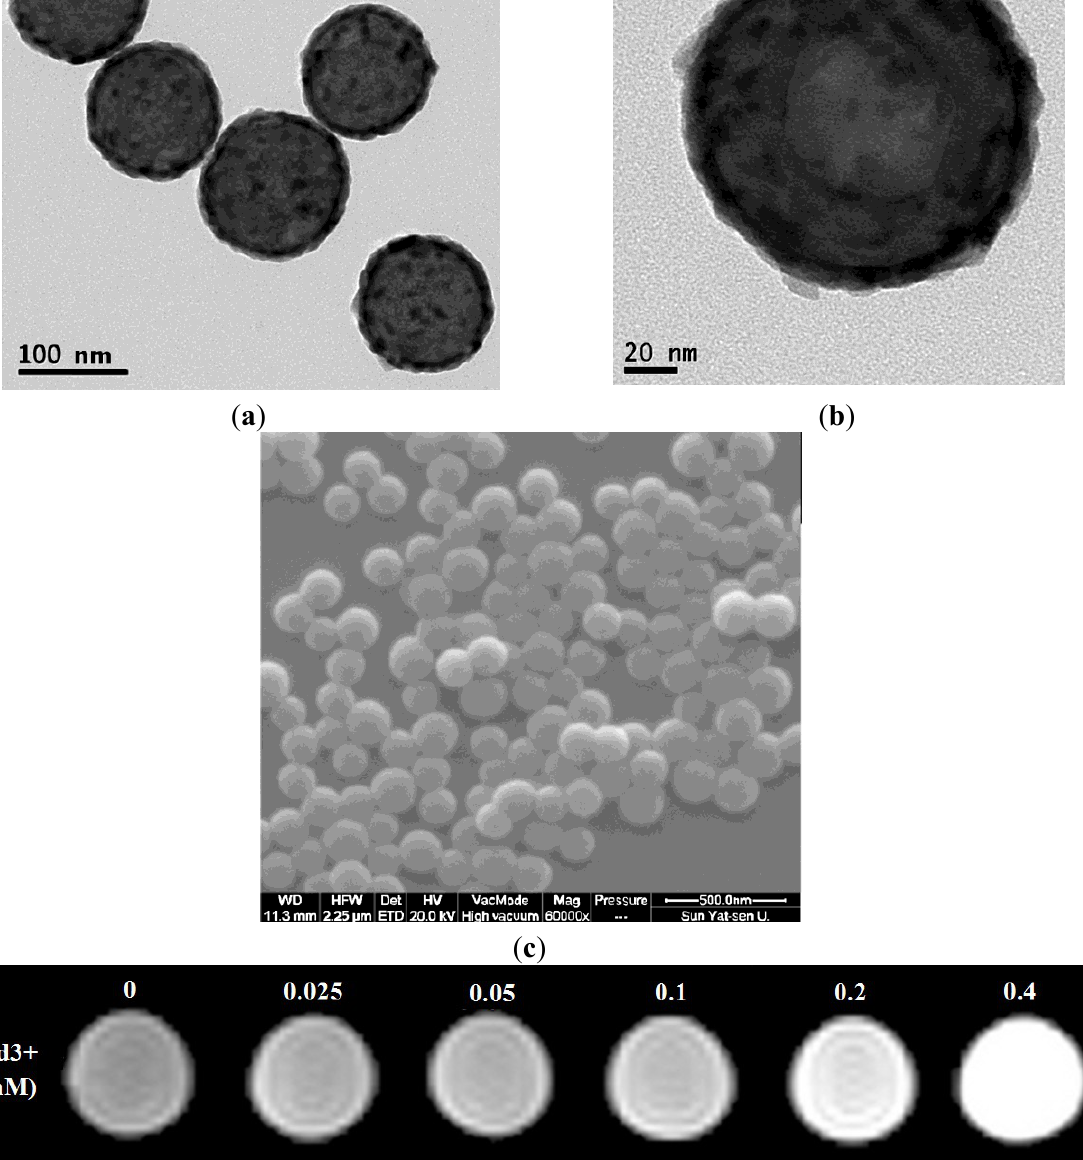
Figure 1. Characterization of the dual-modality nanoprobes. ( a , b ) transmission electron microscopy (TEM) micrograph and typical histograms for the dual-modality nanoprobes and SEM ( c ); ( d ) T -weighted phantom MR image of the nanoprobes with Gd 3+ 1 concentrations of 0.025, 0.05, 0.1, 0.2 and 0.4 mM at 1.5 T; and ( e ) The relaxivity ( r